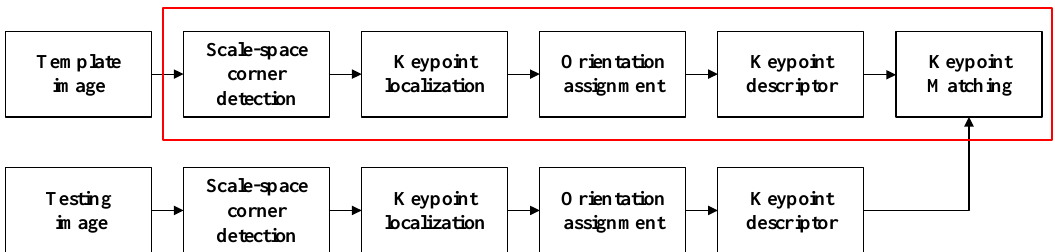
Figure 1. A flow chart indicates the template image and testing image are both utilized the proposed FBRLF method to compare the similarity. The procedure of the proposed FBRLF method is shown as the red